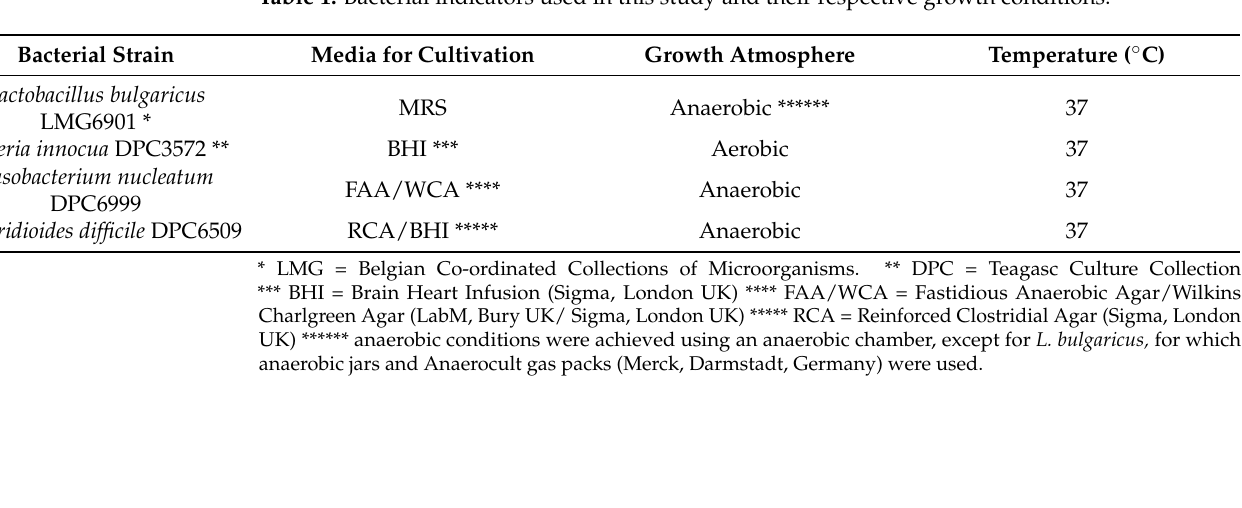
Table 1. Bacterial indicators used in this study and their respective growth